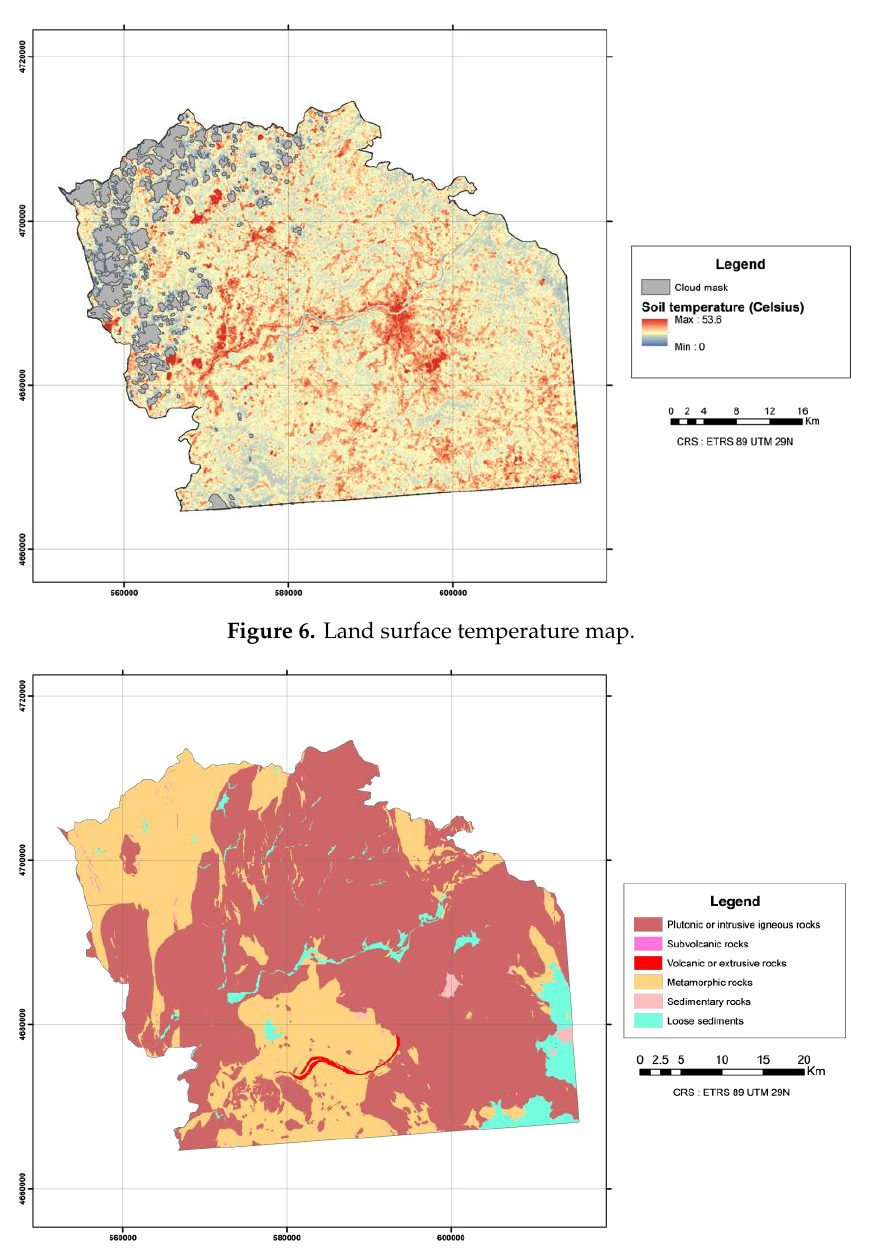
Figure 7. Geological map with the six reclassified informational classes.